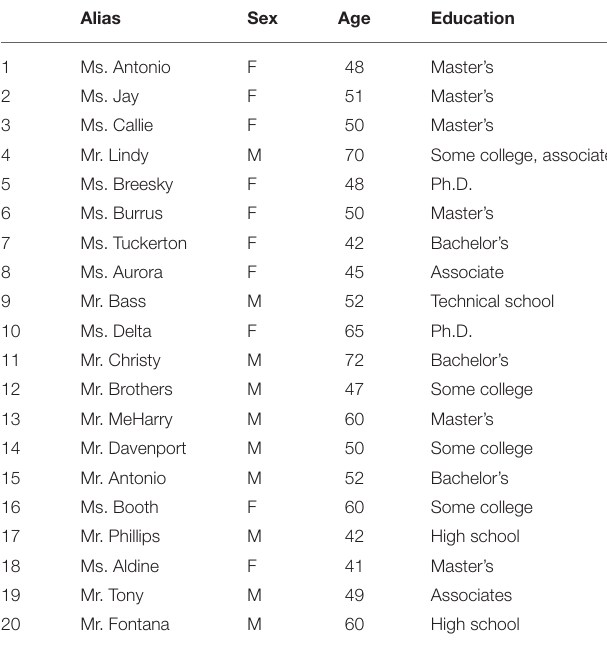
TABLE 1 | Demographic Information of